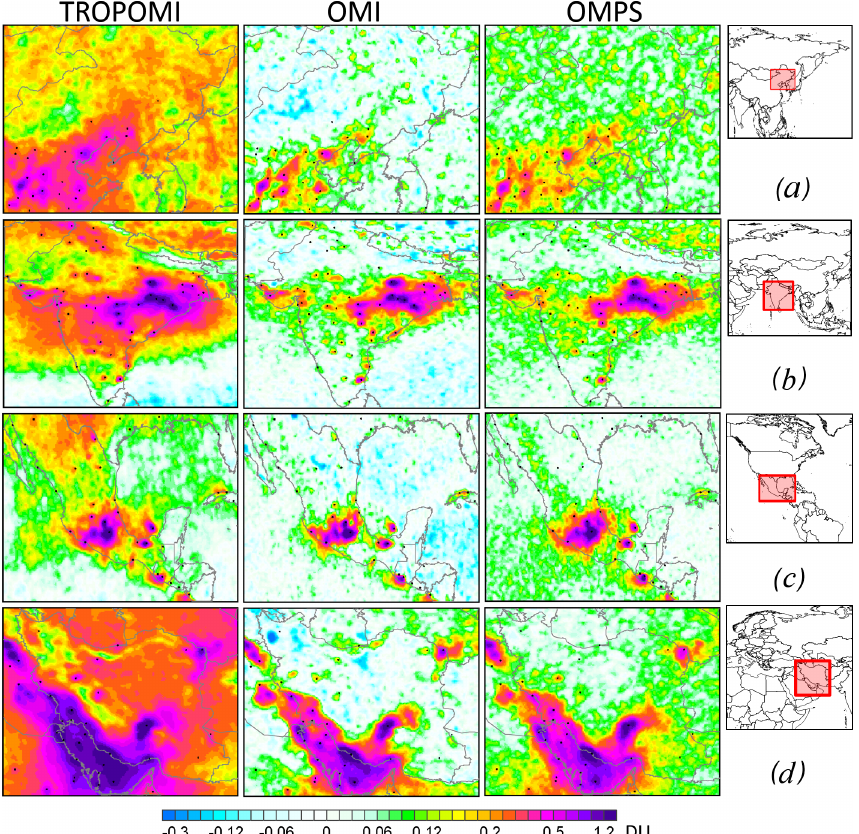
Figure 4. Mean SO 2 (DU) from TROPOMI, OMI, and OMPS over northern China (a) , India (b) , Mexico (c) , and Iran (d) for the period from April 2018 to March 2019. Large-scale biases make it difficult to interpret TROPOMI SO 2 data and compare them to OMI and OMPS data directly. Data are smoothed by oversampling techniques with R = 30km. The black dots indicate the SO 2 sources. Note that the colour scale is different from the scale in Fig. 3.